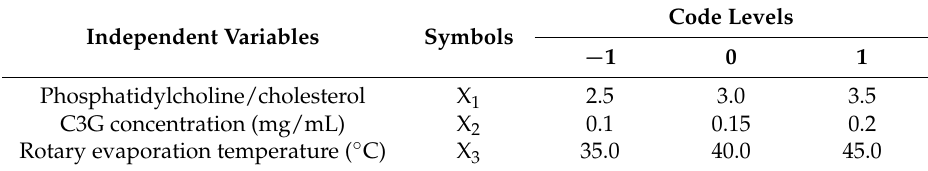
Table 5. Predicted optimum conditions for the preparation of C3G